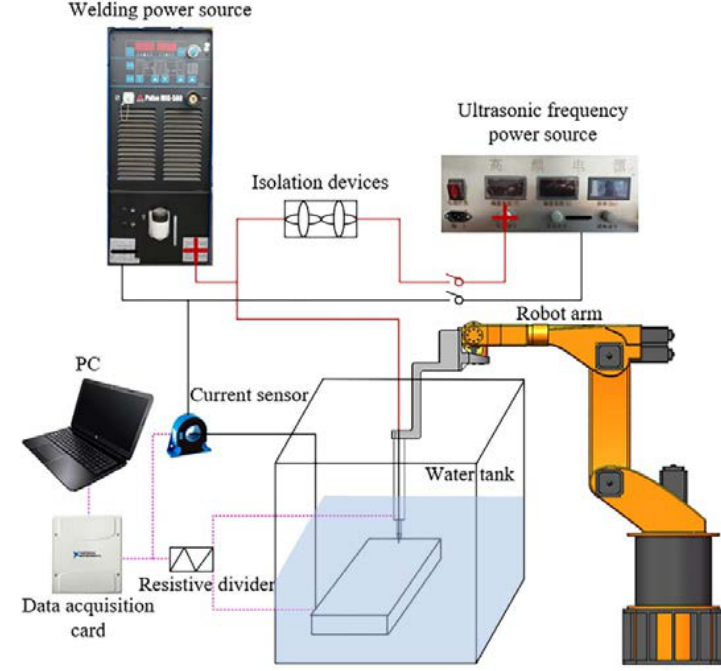
Figure 2. Schematic diagram of the UFP-UWFCAW process.